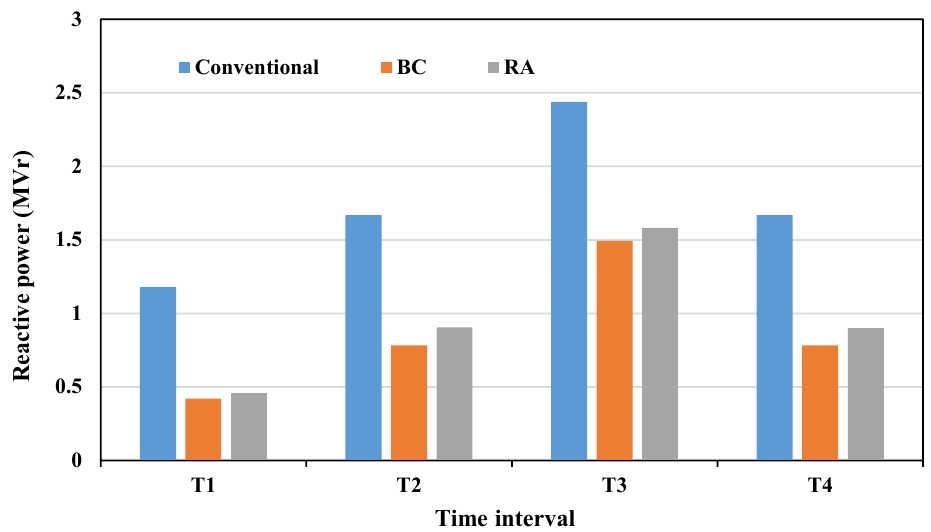
Figure 8. Imported reactive power from the main grid in different cases (on-grid operation mode).